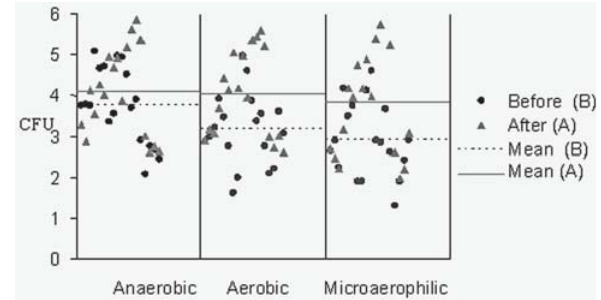
FIGURE 3- Graphic representation of microorganism count logarithms in CFUs relative to Group 3 TABLE 2- Mean and standard deviation (SD) of microorganism counts transformed into logarithms and the Student T test to compare the count means before and after application of treatment